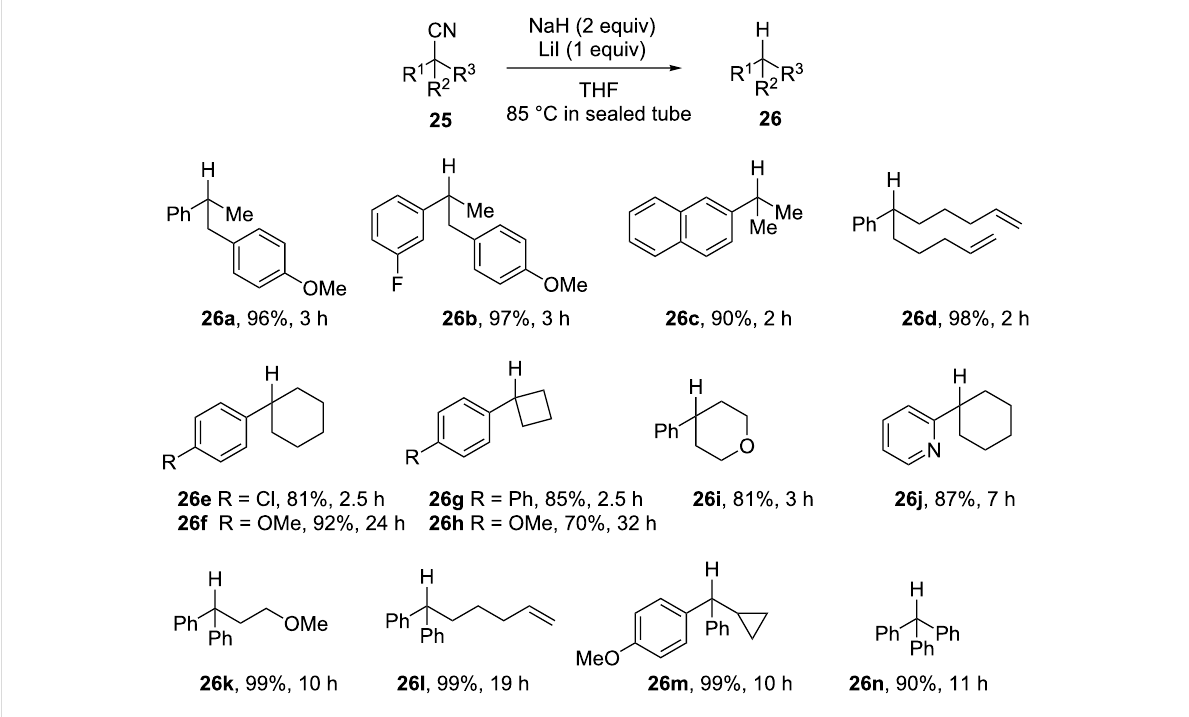
Scheme 11: Reductive decyanation by a sodium hydride–iodide composite (26 examples)